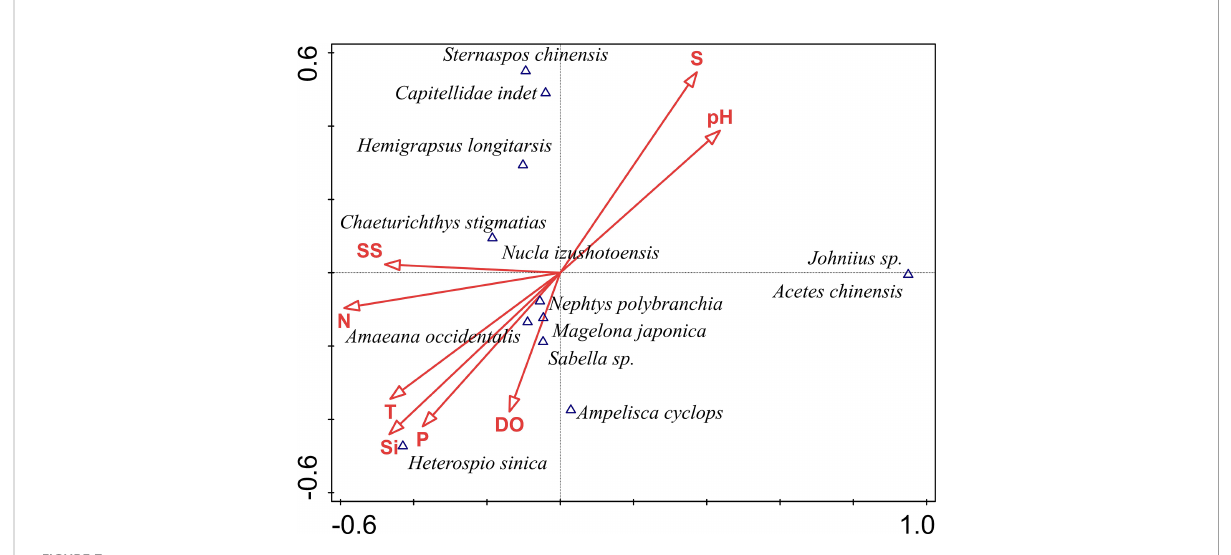
FIGURE 7 CCA ranking of macrobenthos and environmental factors in Hangzhou Bay. P: PO 3 − 4 ; T: temperature; SS: suspended solids; DO: dissolved oxygen; S: salinity; N: dissolved inorganic nitrogen; Si: SiO −